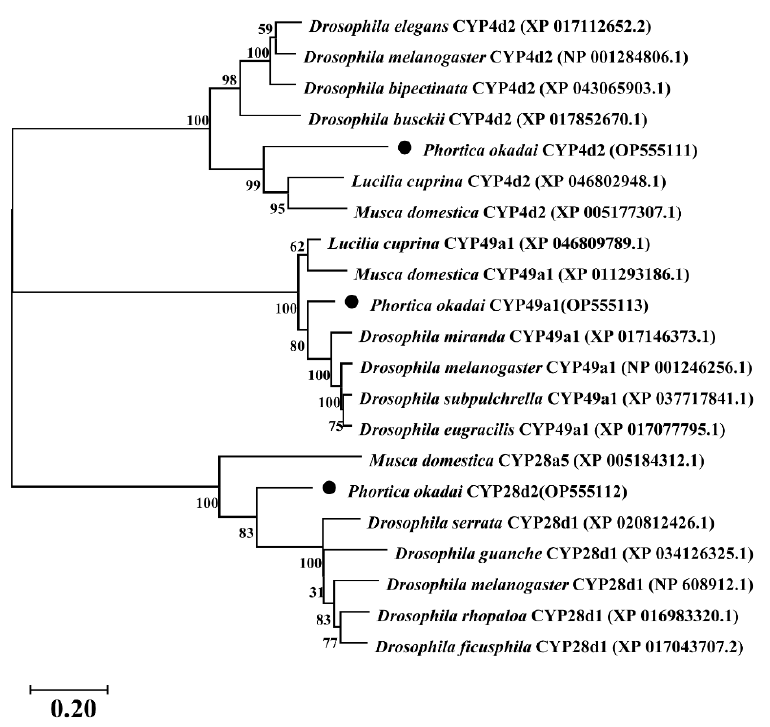
Figure 1. Phylogenetic analysis of CYP4D2, CYP49a1, and CYP28D2 of Phortica okadai and related P450s. The scale bar indicates 0.20 amino acid substitutions per site and the branch length represents genetic distance and the value on the branch is the support rate. The three P. okadai CYP450s are indicated by “ ● ”.